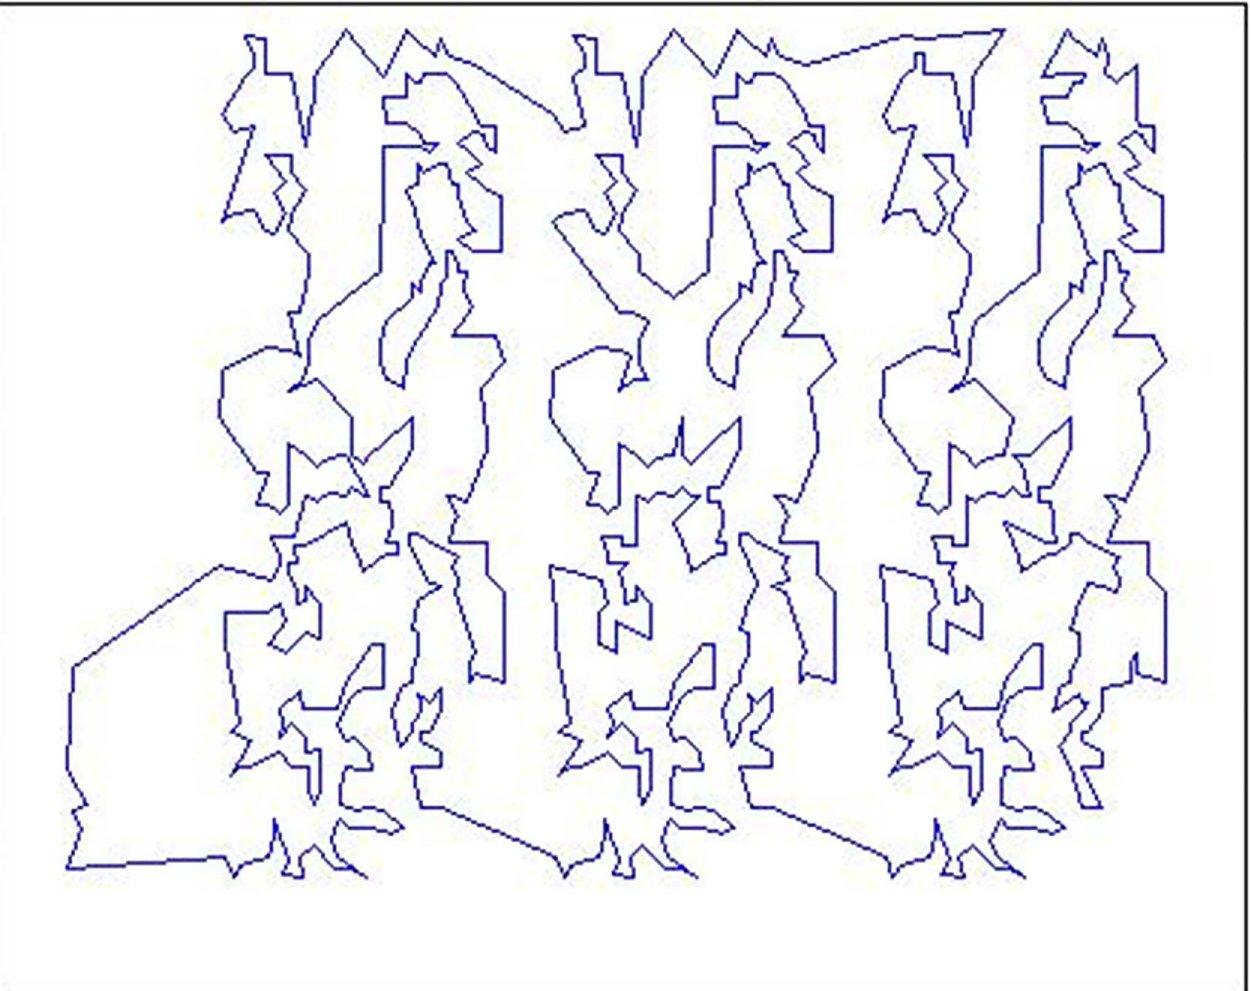
Fig 5. An EXE improved tour for